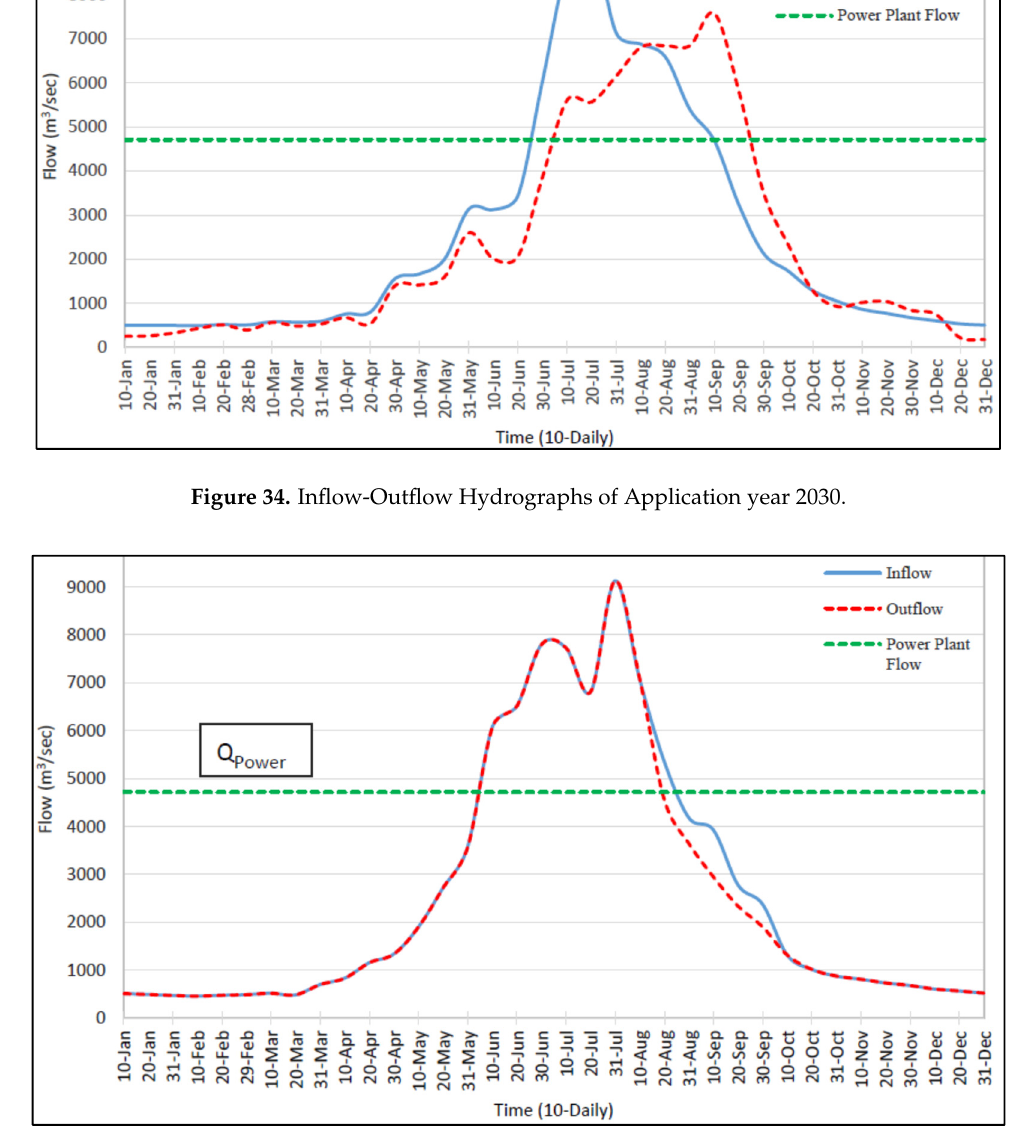
Figure 35. Inflow-Outflow Hydrographs of Application year 2035.